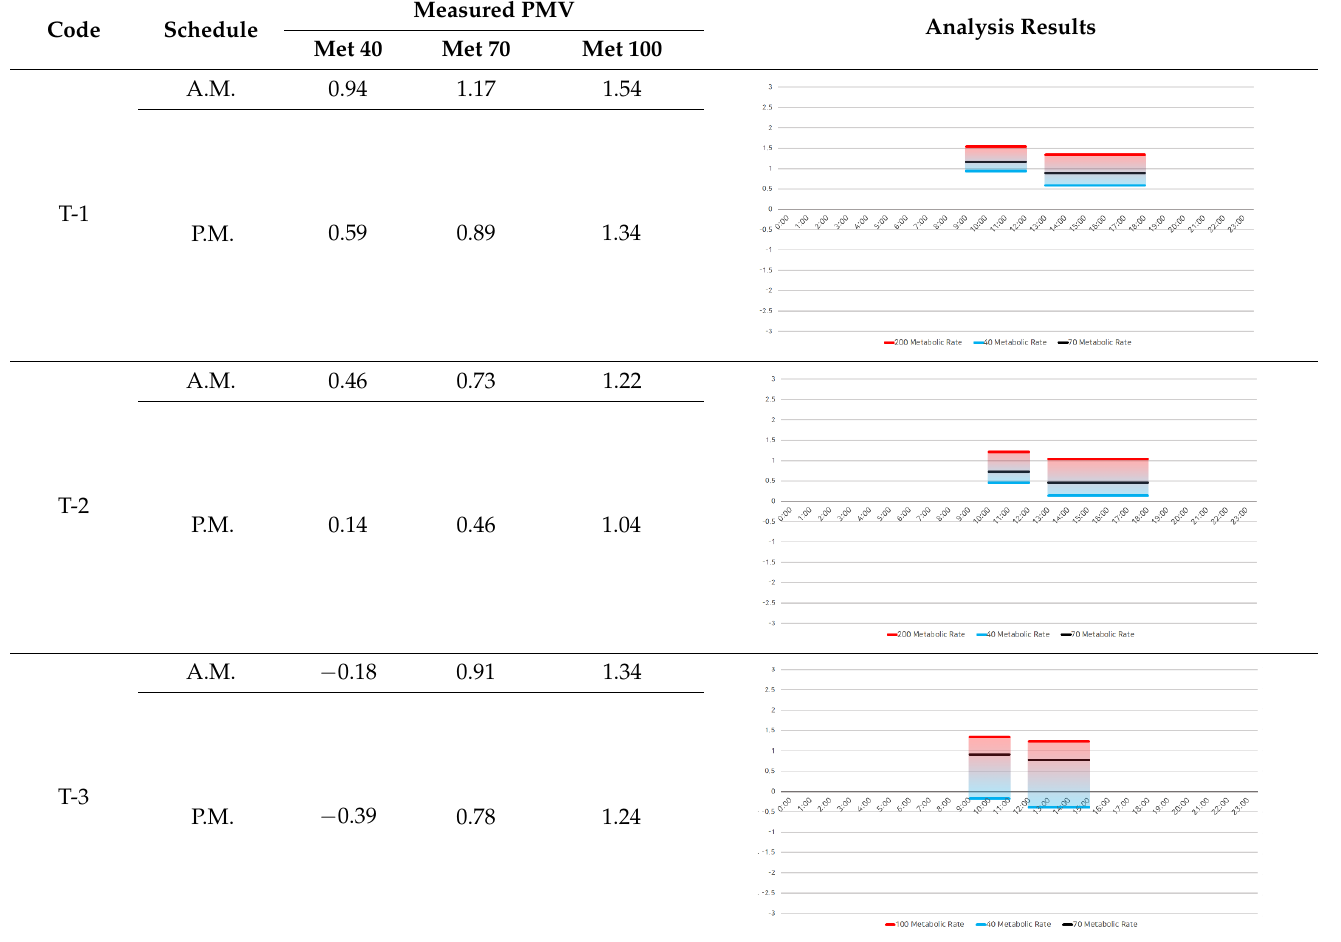
Table 6. Calculated PMV ranges per operation schedule for target